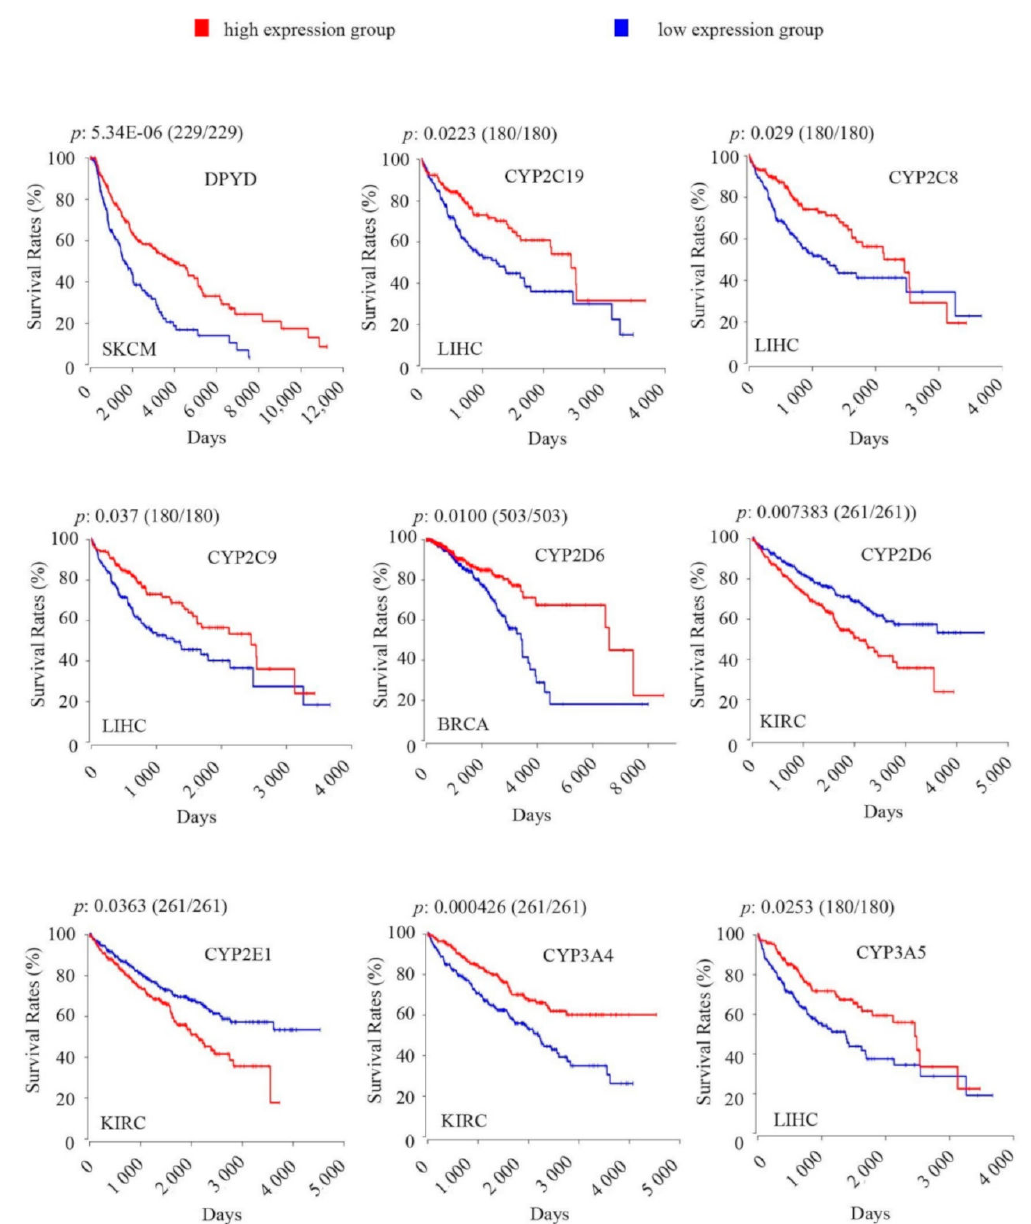
Figure 1. Kaplan-Meier survival analysis and logrank test show significant associations of intratumoral expression levels of core ADME (absorption, distribution, metabolism, and excretion) genes coding for phase I drug-metabolizing enzymes with overall survival rates in TCGA cancers. For Kaplan-Meier survival analysis, the patients were separated into high-expression group (upper 50 percentile, red curve) and low-expression group (lower 50 percentile, blue curve) by gene expression levels in each TCGA cancer type as indicated. The number of patients in each group was given in bracket following the p -value. A Bonferroni-corrected cuto ff logrank p -value of < 0.05 indicates statistical